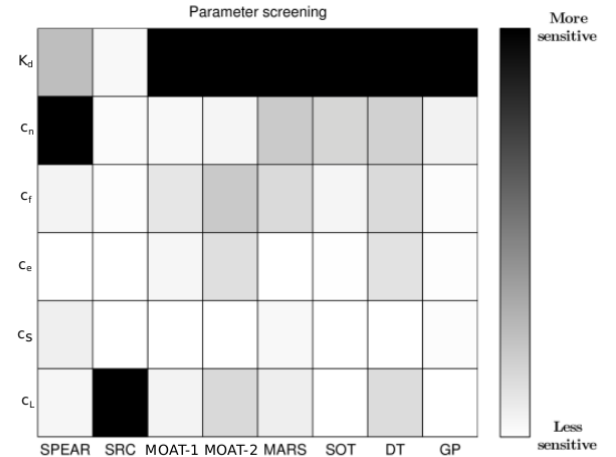
Figure 2. Comparison of the relative sensitivity of a subset of the parameters of the Canadian Small Lake Model, using the Nash– Sutcliffe performance to evaluate the model.